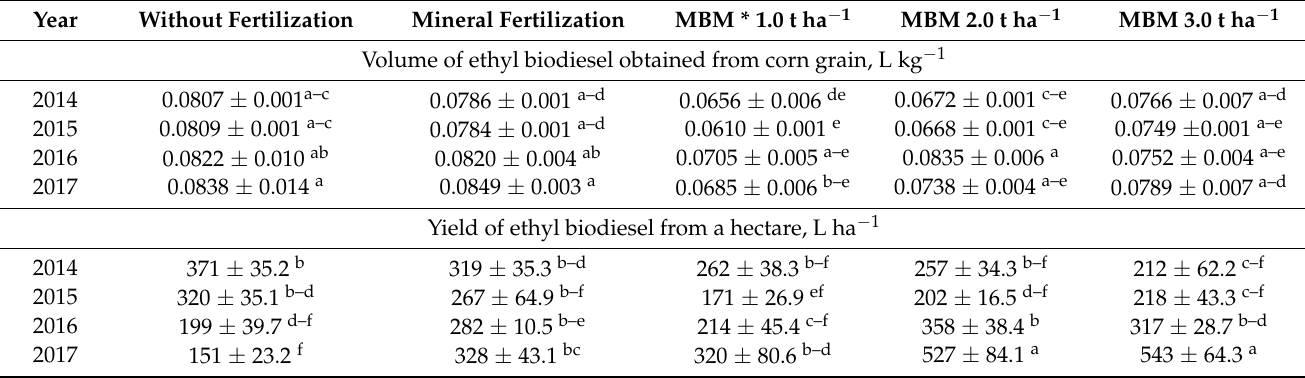
Table 9. Interaction between the years and treatments for volume of ethyl biodiesel obtained from corn grain, and yield of ethyl biodiesel from a hectare, (mean value and standard deviation). Without Fertilization Mineral